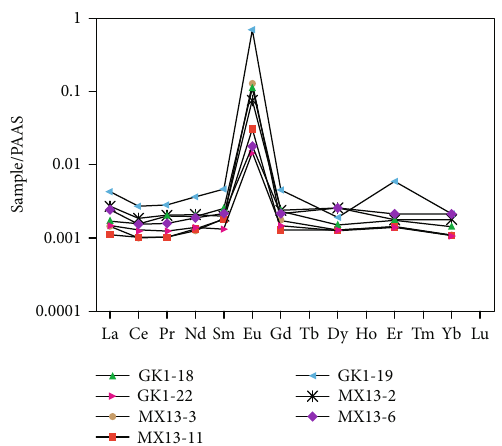
Figure 5: PAAS-normalized plot of the rare earth elements in the Upper Ediacaran reservoir solid bitumens (PAAS from